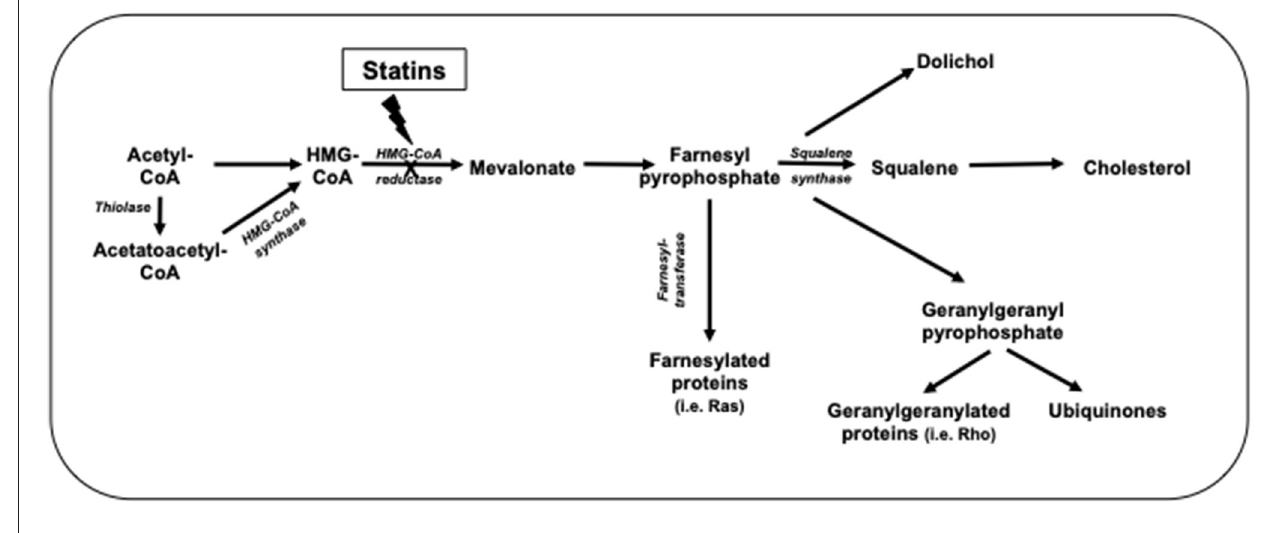
FIGURE 2 | Cholesterol biosynthetic pathway.